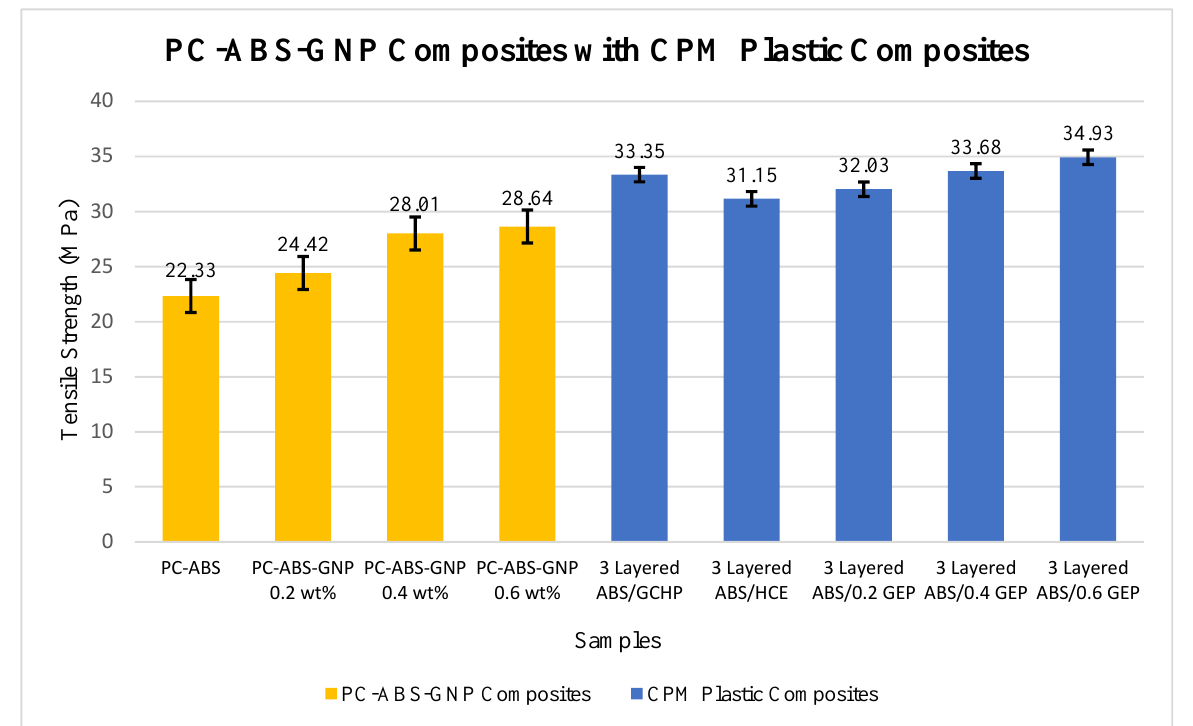
Figure 19. Results of PC – ABS – GNP composites compared with those of CPM plastic composites.